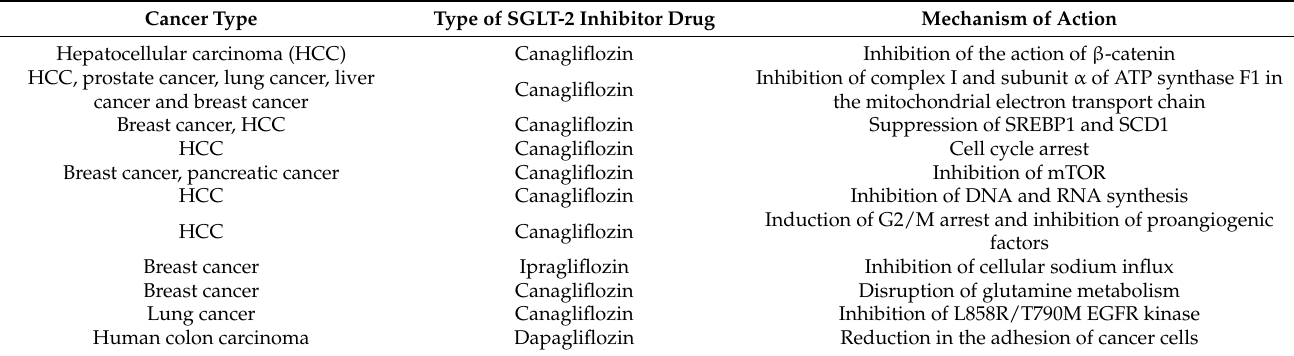
Table 2. Mechanisms of anticancer action of SGLT-2